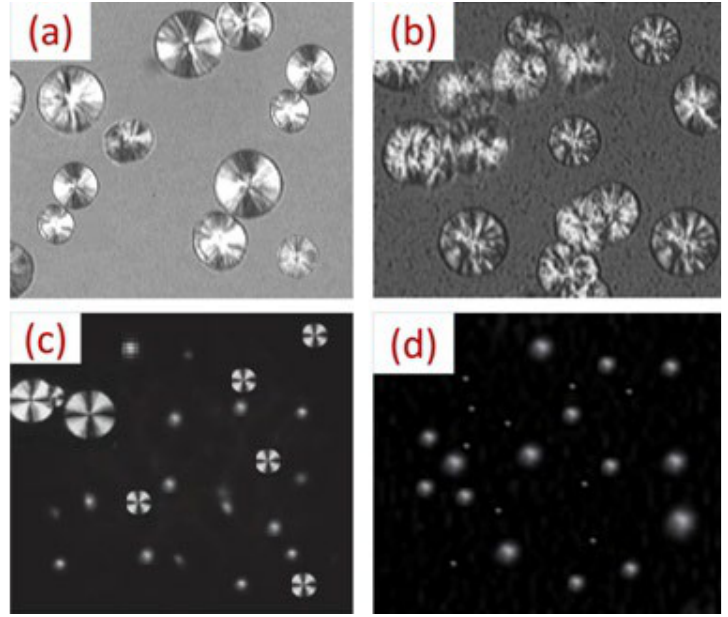
Figure 12. Polarized optical micrographs of ( a ) PP, ( b ) PP-H5-3, ( c ) PP-H15-3 and ( d ) PP-H25-3 at 110 °C and ×50 magnification.